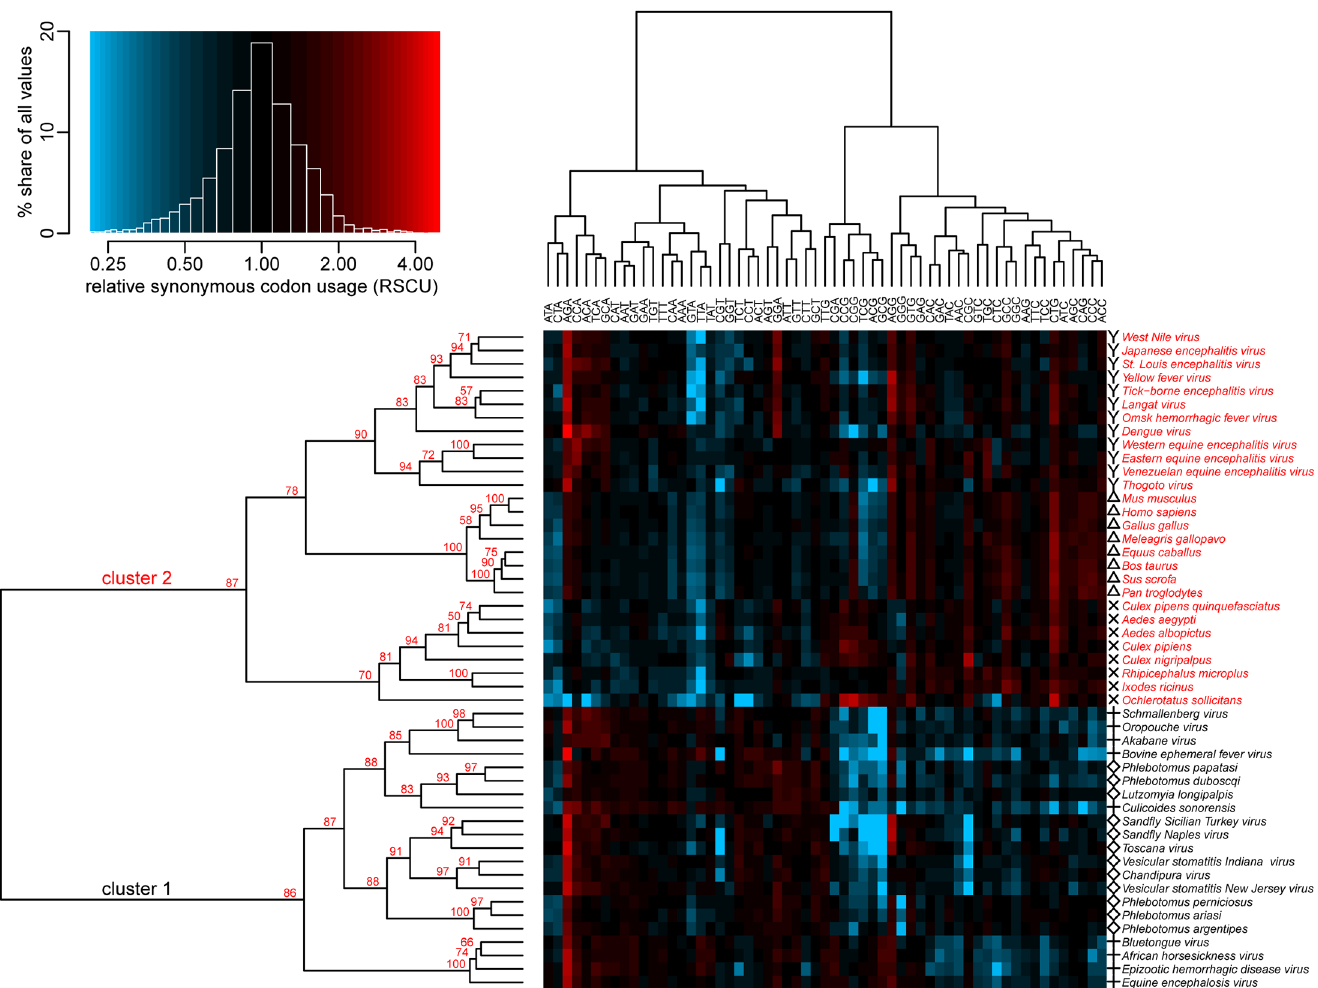
Fig 2. Influence of host on codon usage in arboviruses. The two-way hierarchical cluster analysis shows a correlation of the RSCU between viruses and their respective hosts. In the first dimension, viral and invertebrate species were split into two main clusters, while vertebrate species clustered together, in the second dimension, there was a contrasting pattern between species based on their preference for A/T or G/C-end codons. The cluster analysis was done with centered and scaled RSCU values, but cell colors in the heat map represent the original values. High RSCU values are shown in red and low values in blue; values around 1 are shown in black. The AU p-values from a multiscale bootstrap analysis (n = 10000) are overlaid over the first-dimension dendrogram.